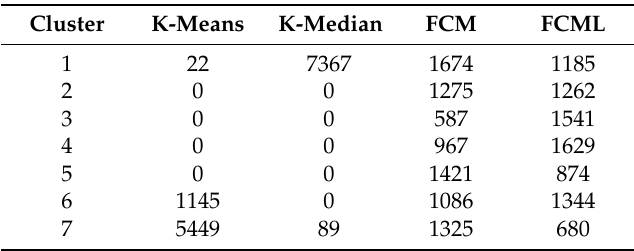
Table 3. The number of line segments in each cluster using K-means, K-median, and FCML (K =